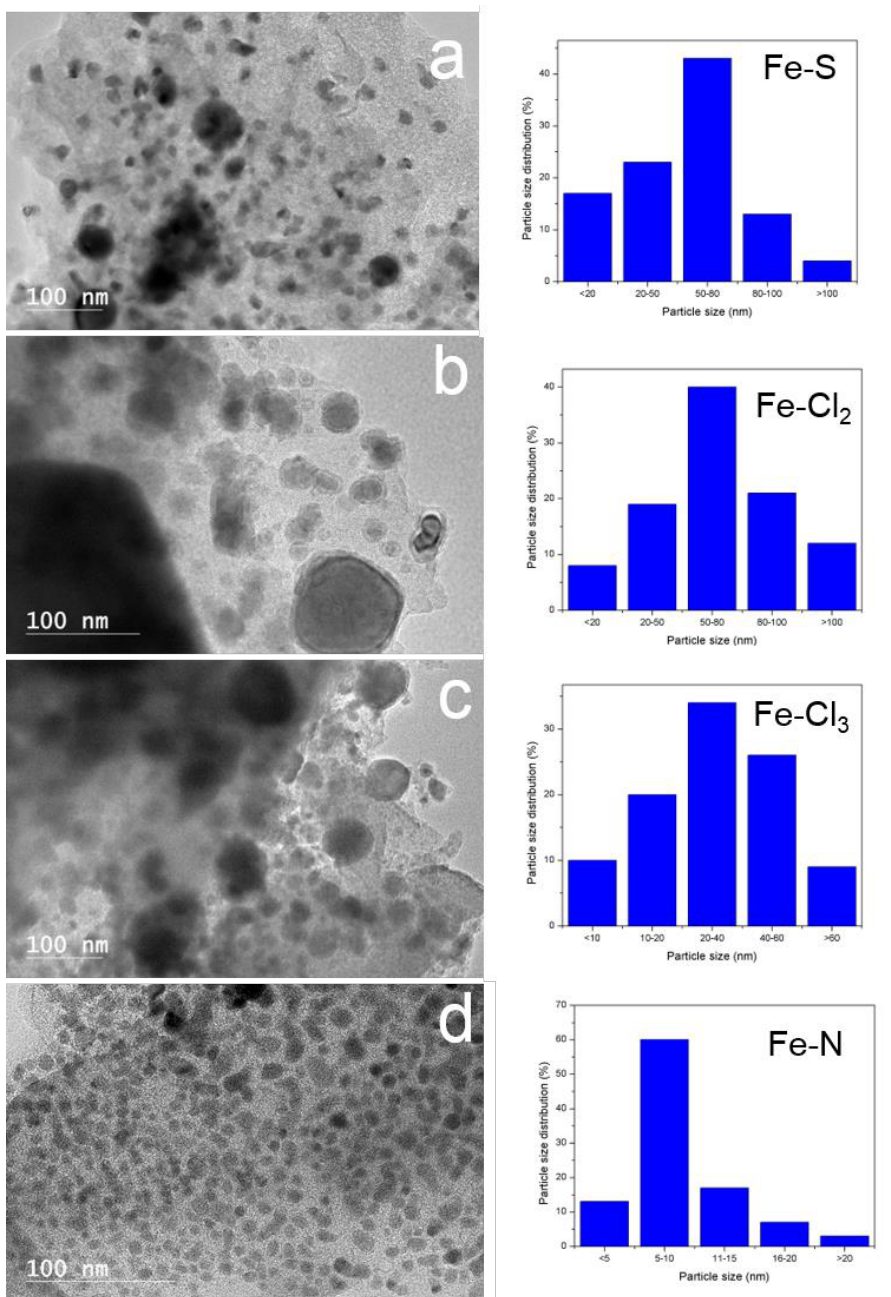
Figure 6. High resolution transmission electron microscope images of four iron sources (iron(II) sulfate ( a ) iron(II) chloride ( b ), iron(III) chloride ( c ) and iron nitrate ( d )) promoted kraft lignin after thermal-treated at 1000 °C for 1 h under an argon flow.